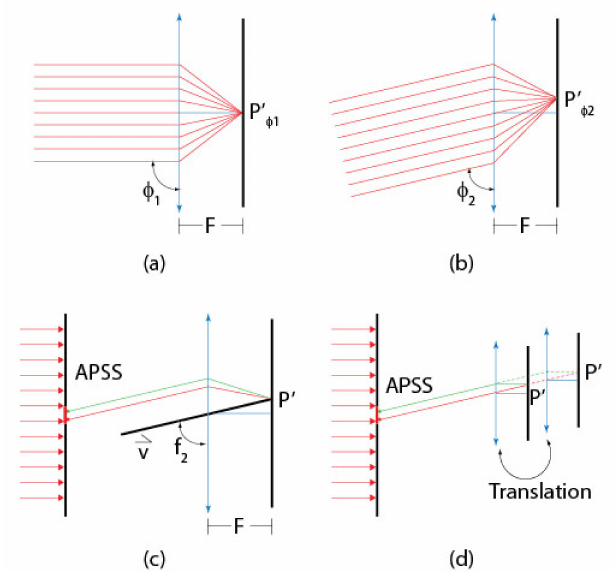
Figure 13. Using defocused speckle for measuring rotations. Collimated light at orientation φ 1 generates a point P (cid:48) φ 1 on the speckle pattern ( a ). When the collimated light originates from orientation φ 2 relative to the optical axis, the speckle point moves to position P (cid:48) φ 2 on the image plane ( b ). The mapping between orientation and position is encoded by direction vector not affect the orientation-position mapping ( d ). The APSS in the figure is a source of speckle (see